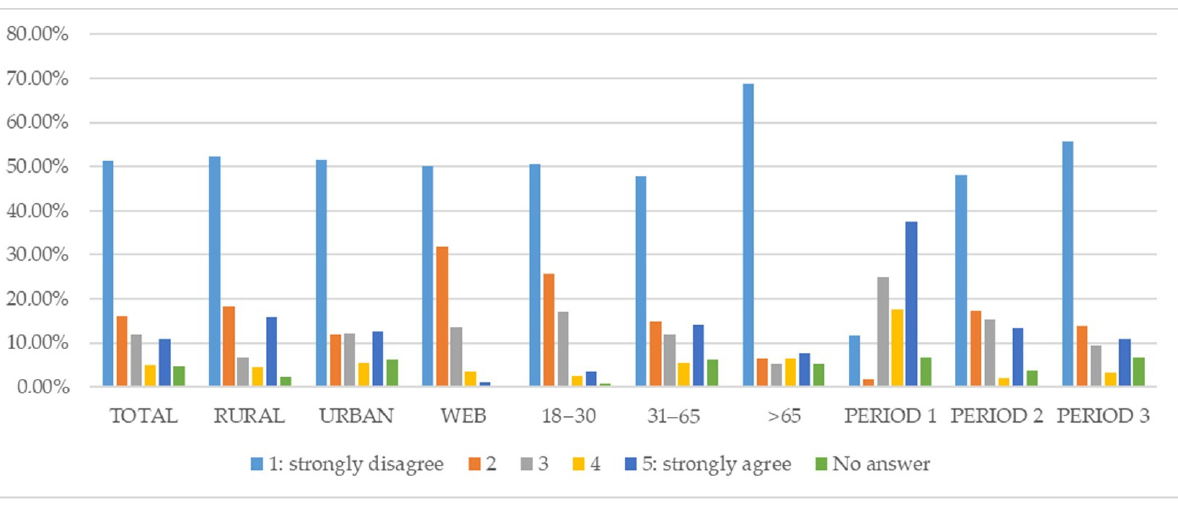
Figure 2. Customer opinion about the prospect that the pharmacy may become an online service in the future.